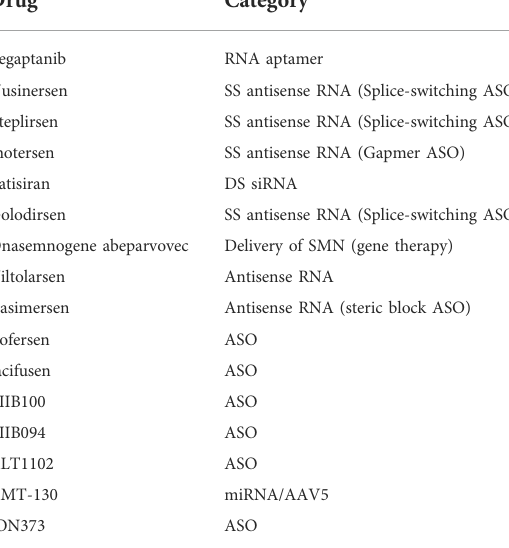
TABLE 3 Approved/under trial NBTs for CNS